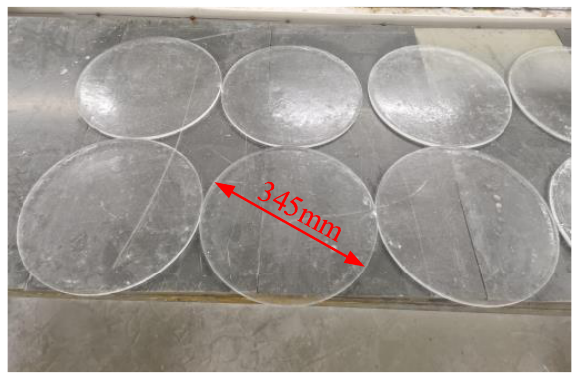
Figure 4. Ice plate